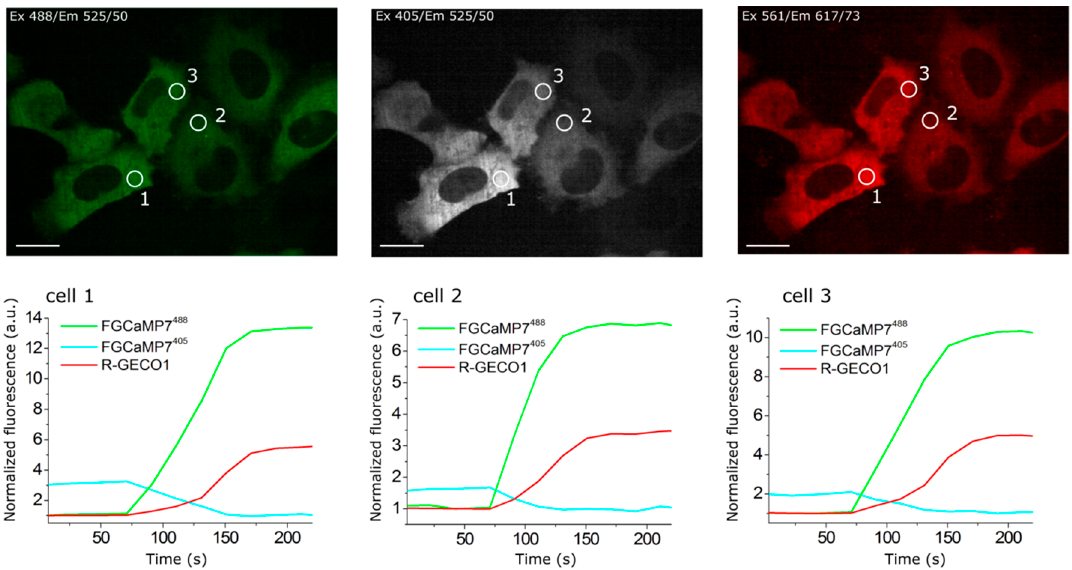
Figure 2. The response of the FGCaMP7 indicator to variations in cytoplasmic calcium concentration in HeLa Kyoto cells. (Upper panels) Confocal images of HeLa Kyoto cells co-expressing ratiometric indicator FGCaMP7 at 488 nm (left panel) and 405 nm (middle panel) excitations and red indicator R-GECO1 at 561 nm excitation (right panel). (Lower panels) The graphs illustrate changes in green fluorescence of FGCaMP7 at 488 nm (green lines) and 405 nm (cyan lines) excitations and red fluorescence of co-expressed R-GECO1 (red lines) GECI in response to 2.5 µ M ionomycin. Changes in fluorescence are shown for three cells. The changes shown in graphs correspond to the areas indicated with white circles in the images in upper panels. Scale bar: 20 μ m.